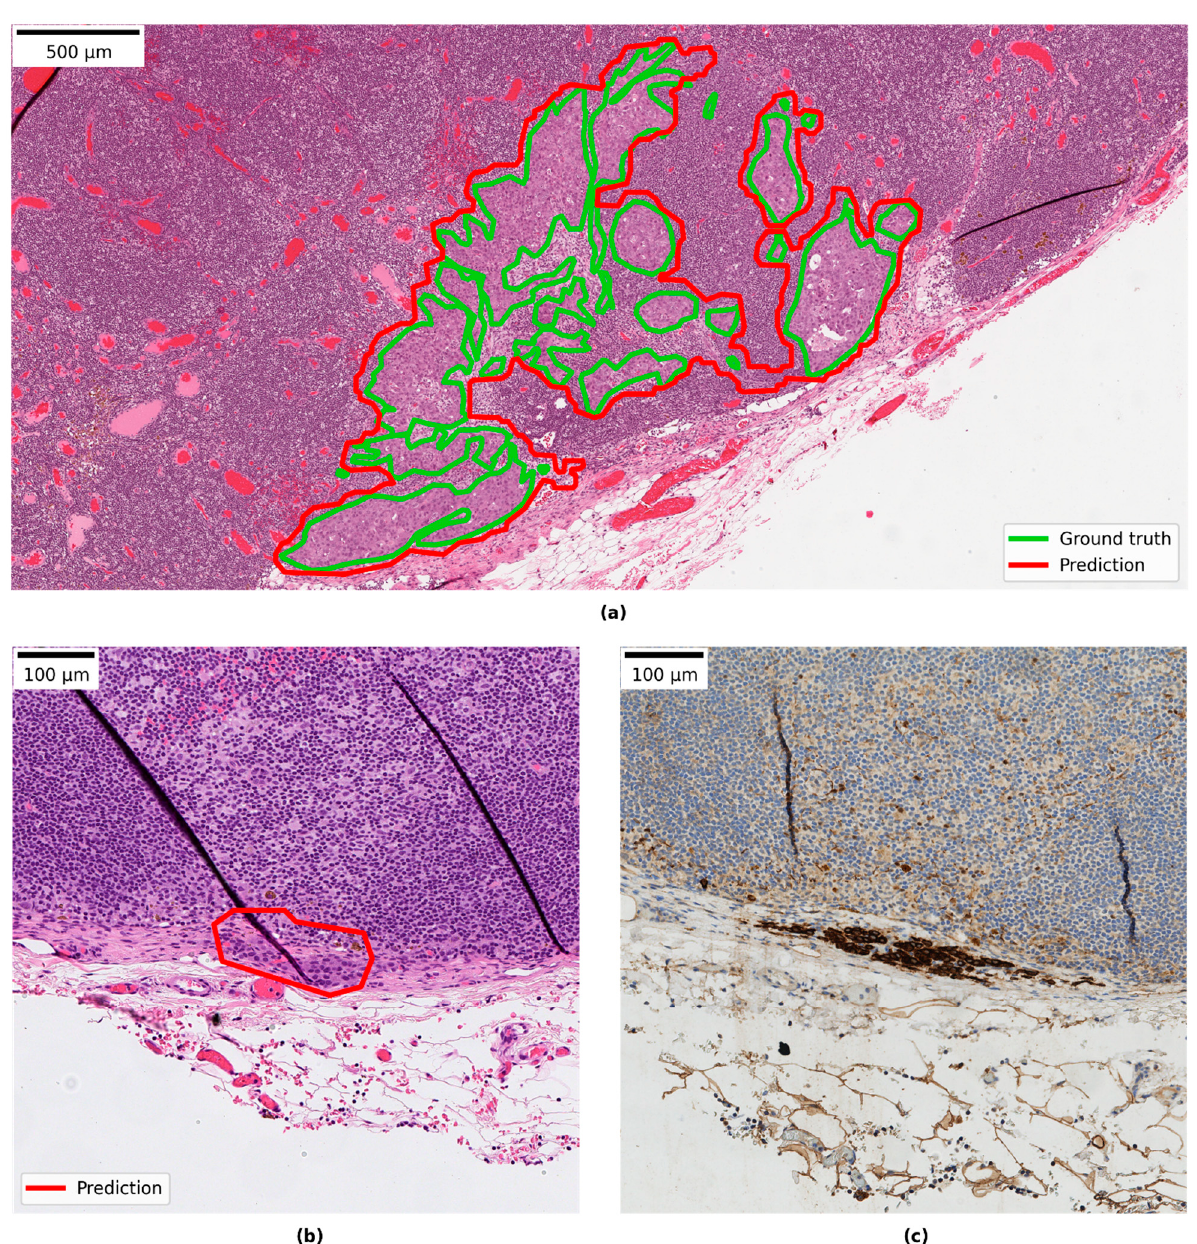
Figure 4. ( a ) Example of ground-truth annotation and model prediction detection area overlapping; ( b ) example of correct predicted micro-metastasis missed by ground truth; and ( c ) the corresponding immunohistochemistry slide with cytokeratin positive cells.